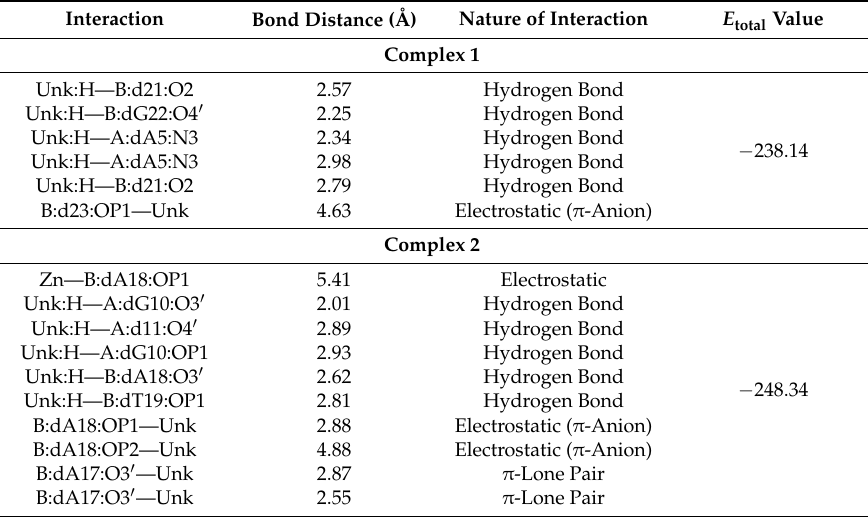
Figure 7. Molecular docking of complexes 1 and 2 with DNA. Panels ( A , C ) represent the binding of complexes 1 and 2 at the major groove of DNA, respectively; and panels ( B , D ) depict the residues of DNA making contacts with complexes 1 and 2 , respectively. Different strands and nucleotides of DNA are represented by separate color (Magenta and Blue in ( A , B ), and Green and Yellow in ( C , D )). Metal complexes 1 and 2 are represented according to element composition. Table 3. Molecular interactions between DNA and complexes 1 and 2